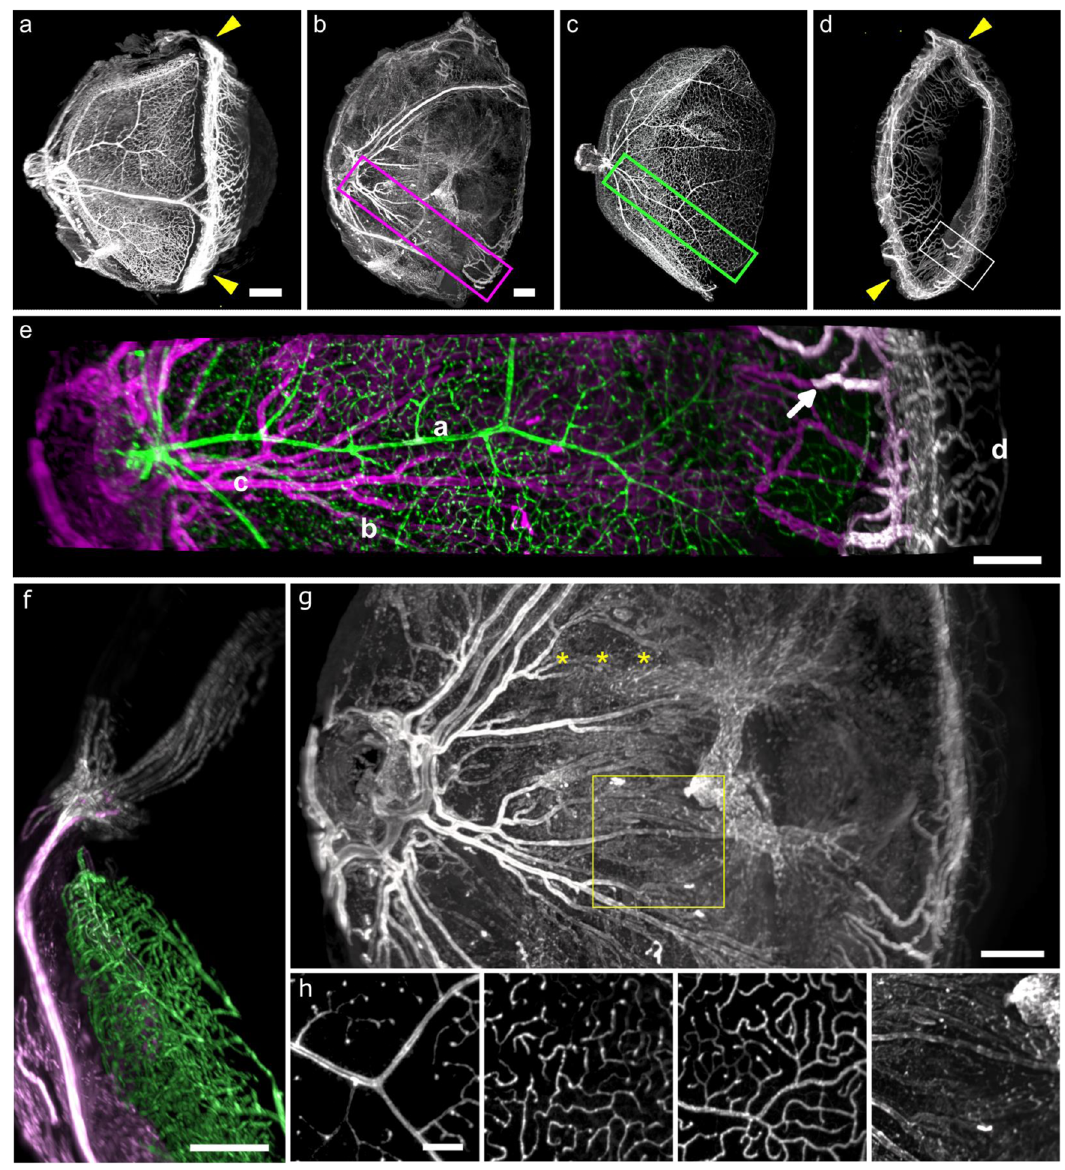
Fig. 1 LSFM imaging of anti-CD31 immunostained cleared balb/c adult mouse ocular vasculature. a – d In toto viewing showing the superimposed scleral and choroidal ( b ), retinal ( c ) and anterior segment (d) circulations (In b to d , the orientation of the eye was slightly rotated compared to a ). Yellow arrowheads: limbus. e : superimposition of the choroid (magenta), retinal (green) and anterior segment circulation (white) from the boxed areas in b and c ( a : retinal artery, b : retinal vein, c : ciliary arteries, d : iris). The arrow points to a connection between a vein of the anterior segment to the choroidal circulation. f : connection of a long ciliary artery (magenta) with the anterior segment circulation (white). g : close-up of the choroid showing ciliary arteries and a vortex vein (yellow asterisks). h : Details of microvascular layers in the boxed area in g . From left to right: super fi cial, intermediary and deep retinal microvascular layers, and choroid (all scale bars are 200 µ